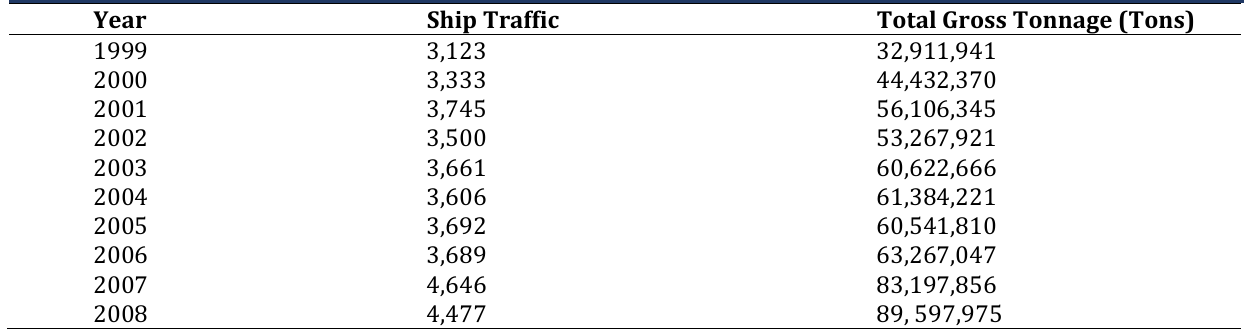
Table 3: Vessel Traffic Pre-Post Concession Era Year